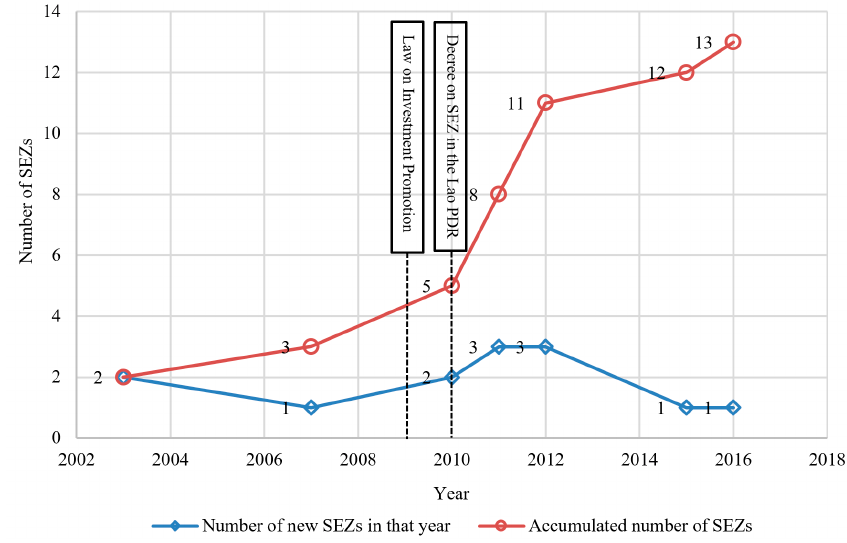
Figure 1. Changes in the number of SEZs in Laos.